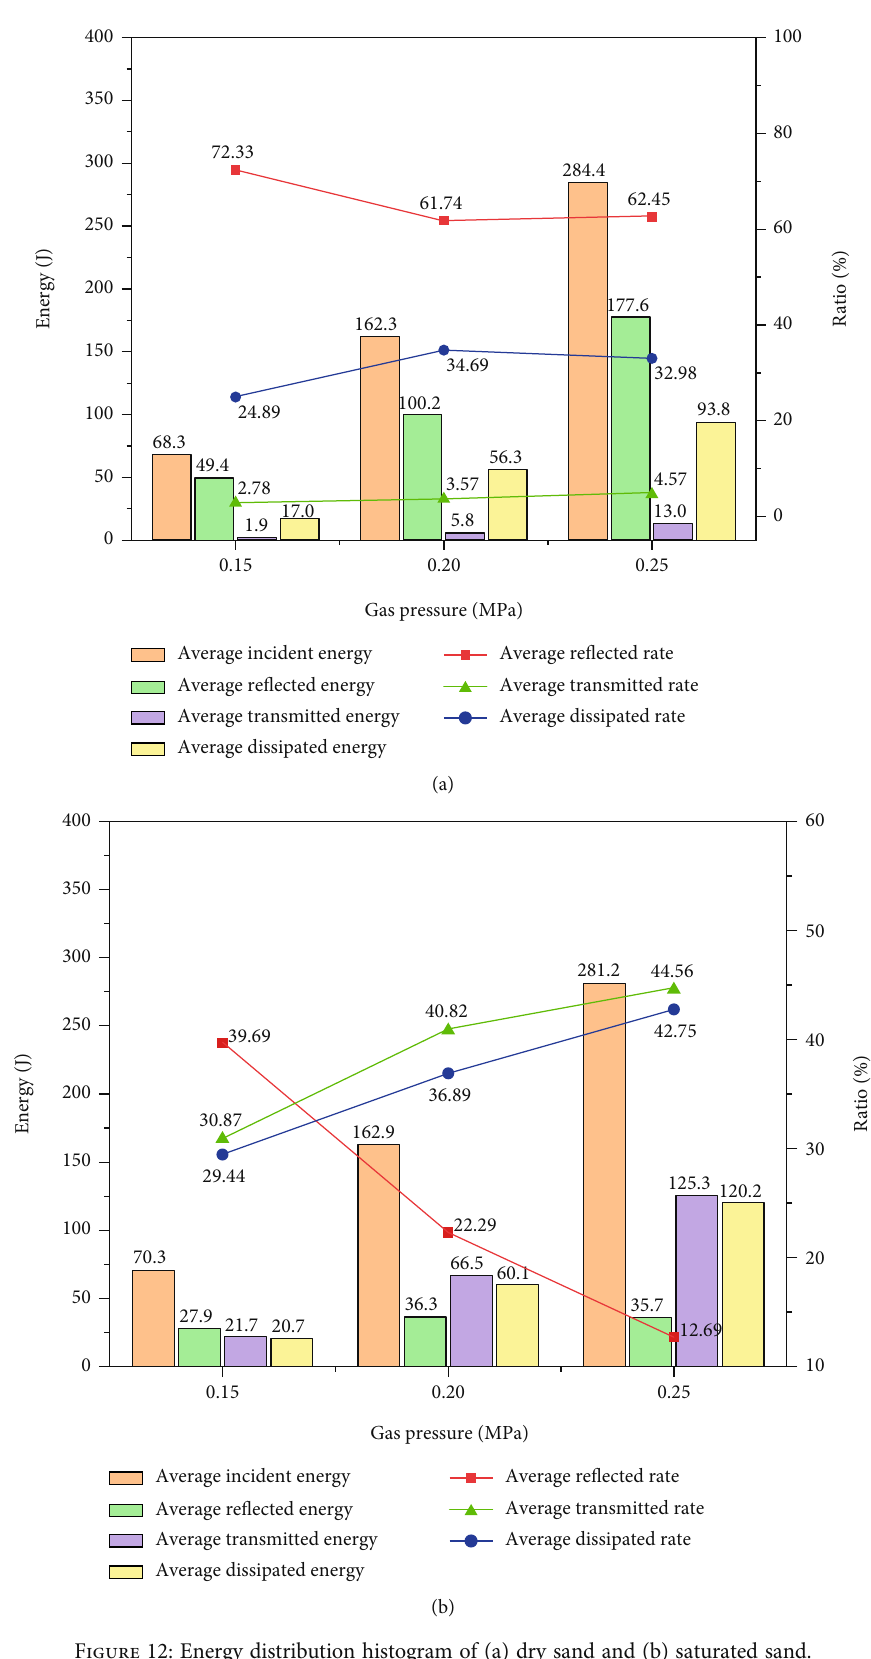
Figure 12: Energy distribution histogram of (a) dry sand and (b) saturated